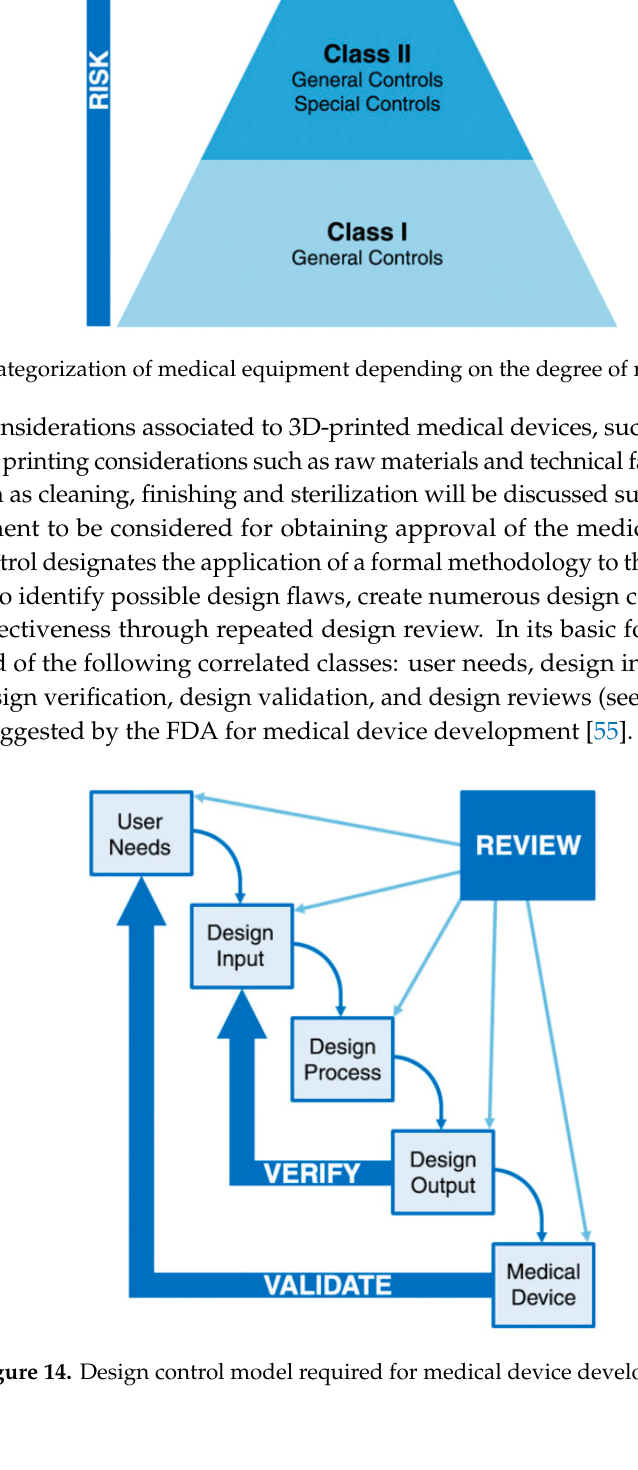
Figure 13. Categorization of medical equipment depending on the degree of risk to the patient.